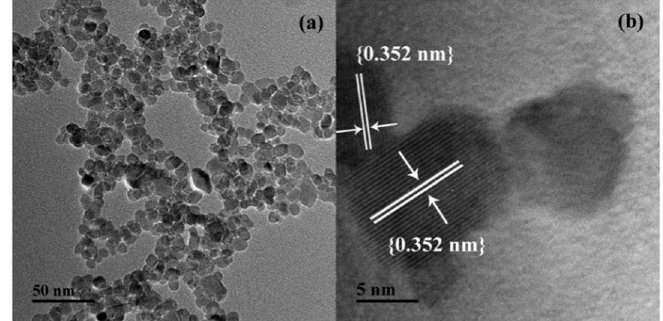
Figure 2. ( a ) TEM and ( b ) HRTEM images of TiO 2 -SO 42 − (Reproduced by permission of The Royal Society of Chemistry, see [17]).